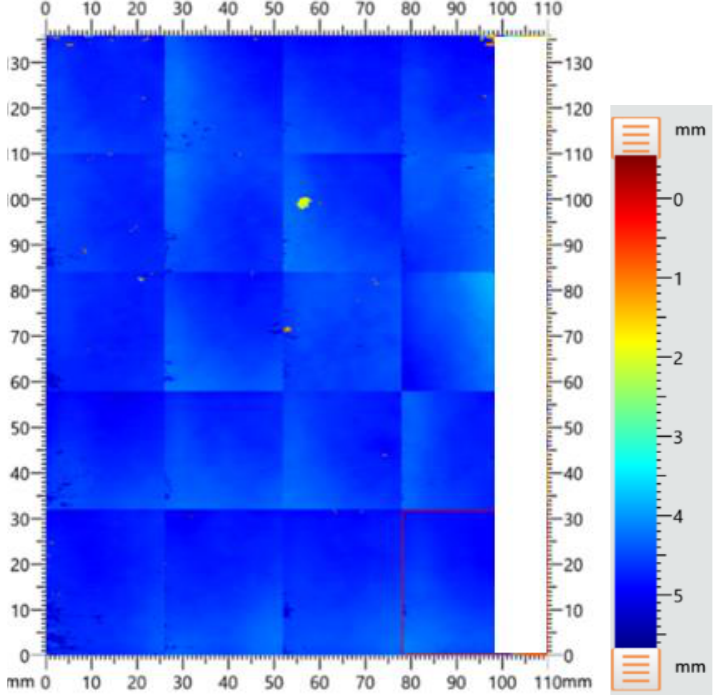
Figure 18. Repaired 3R laminate: C-scan of a representative specimen.